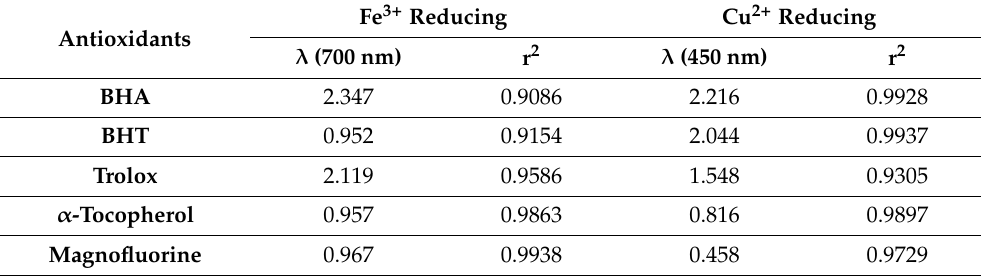
Table 1. Fe 3+ and Cu 2+ reduction abilities of Magnofluorine and positive controls at 30 µ g/mL concentration.